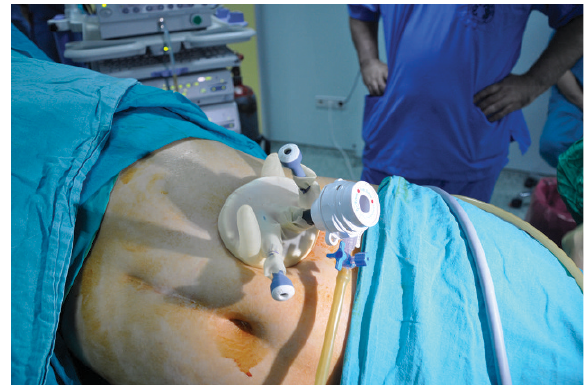
Figure 4 - The spleen was placed in a 15-mm bag, crushed, and removed from the abdominal cavity through the